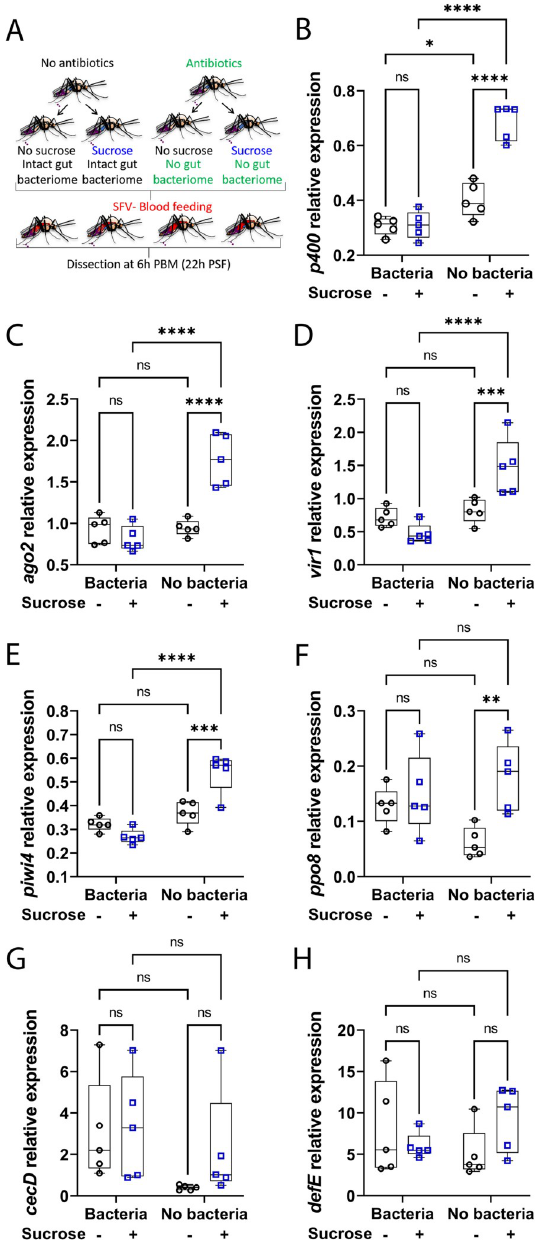
Fig 5. Sugar feeding prior to a blood meal increases antiviral gene expression in blood fed females. (A) Schematic of experimental design. Females, previously treated or not with antibiotics, did not have access to sucrose for 48 h and were either not fed or fed with 10% sucrose. Females received an SFV-infected blood meal at a titre of 7.8 x 10 7 PFU/ mL 16 h post sugar feeding time and digestive tracts were dissected 6 h after the blood meal. PBM, post blood meal; PSF, post sugar feeding. (B to H) RNA transcript levels of (B) p400 , (C) ago2 , (D) vir1 , (E) piwi4 , (F) ppo8 , (G) cecD and (H) defE . Box plots display the minimum, first quartile, median, third quartile, and maximum relative expression levels. N = 5 pools of 5 digestive tracts per condition. Statistical significance of the treatments effect was assessed with a two-way ANOVA (statistical analysis summary of treatment effect and interaction between treatments given in S4 Fig). Pair-wise comparisons shown on the graphs were obtained with a post hoc Fisher’s multiple comparison test (No sucrose vs Sucrose, Bacteria vs No bacteria). ns, p value > 0.05; � , p value < 0.05; �� , p value < 0.01; ��� , p value < 0.001; ���� , p value <